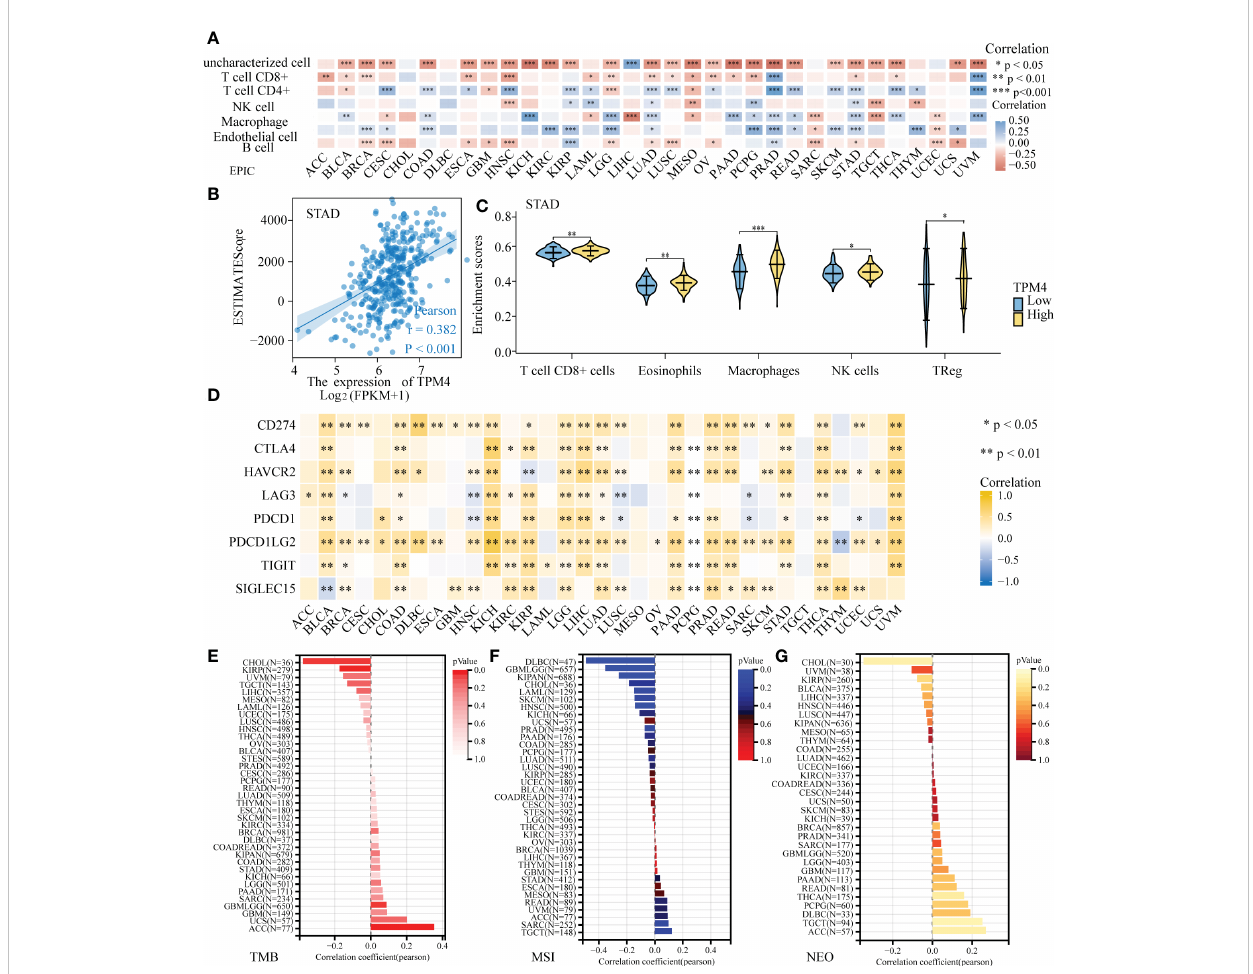
FIGURE 7 Correlation analysis of TPM4 expression and immune in fi ltration. (A) TPM4 expression and immune cell in fi ltration. (B) The relationship between TPM4 mRNA expression and ESTIMATE scores in STAD. (C) . Enrichment scores of TPM4 high and low expression groups in different immune cells of STAD. (D) Correlation analysis of TPM4 expression and immune checkpoints in pan-cancer tissues. (E-G) Correlation of TPM4 expression and tumor mutation burden (TMB, E) microsatellite instability (MSI, F), and neoantigen expression (NEO, G) in pan-cancer tissues. (*P<0.05, **P<0.01,